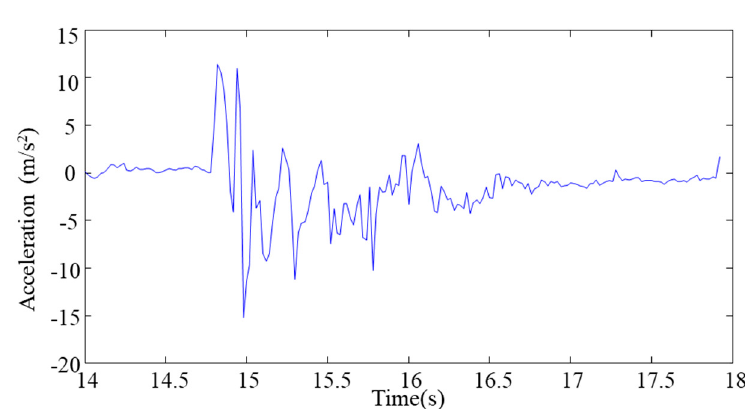
Figure 15. Input seismic ground motion